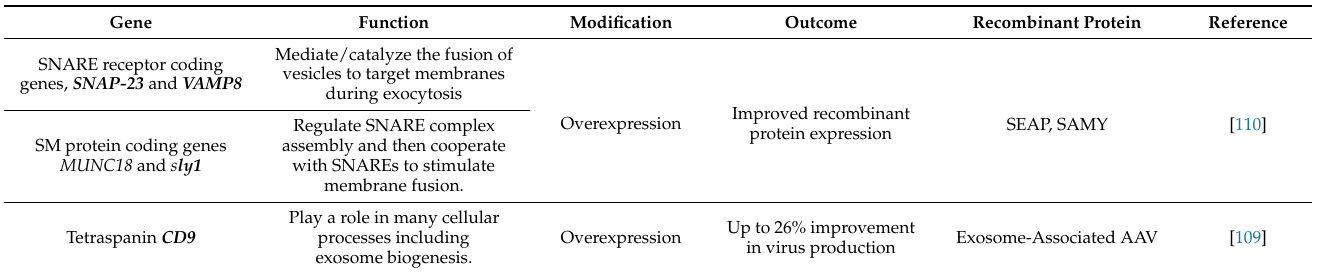
Table 7. Genes that have been engineered to improve the secretory machinery of the HEK293 cell line. Gene Function Modification Outcome Recombinant Protein Reference SNARE receptor coding genes, SNAP-23 and VAMP8 Overexpression Improved recombinant protein expression SEAP, SAMY [110] SM protein coding genes MUNC18 and s